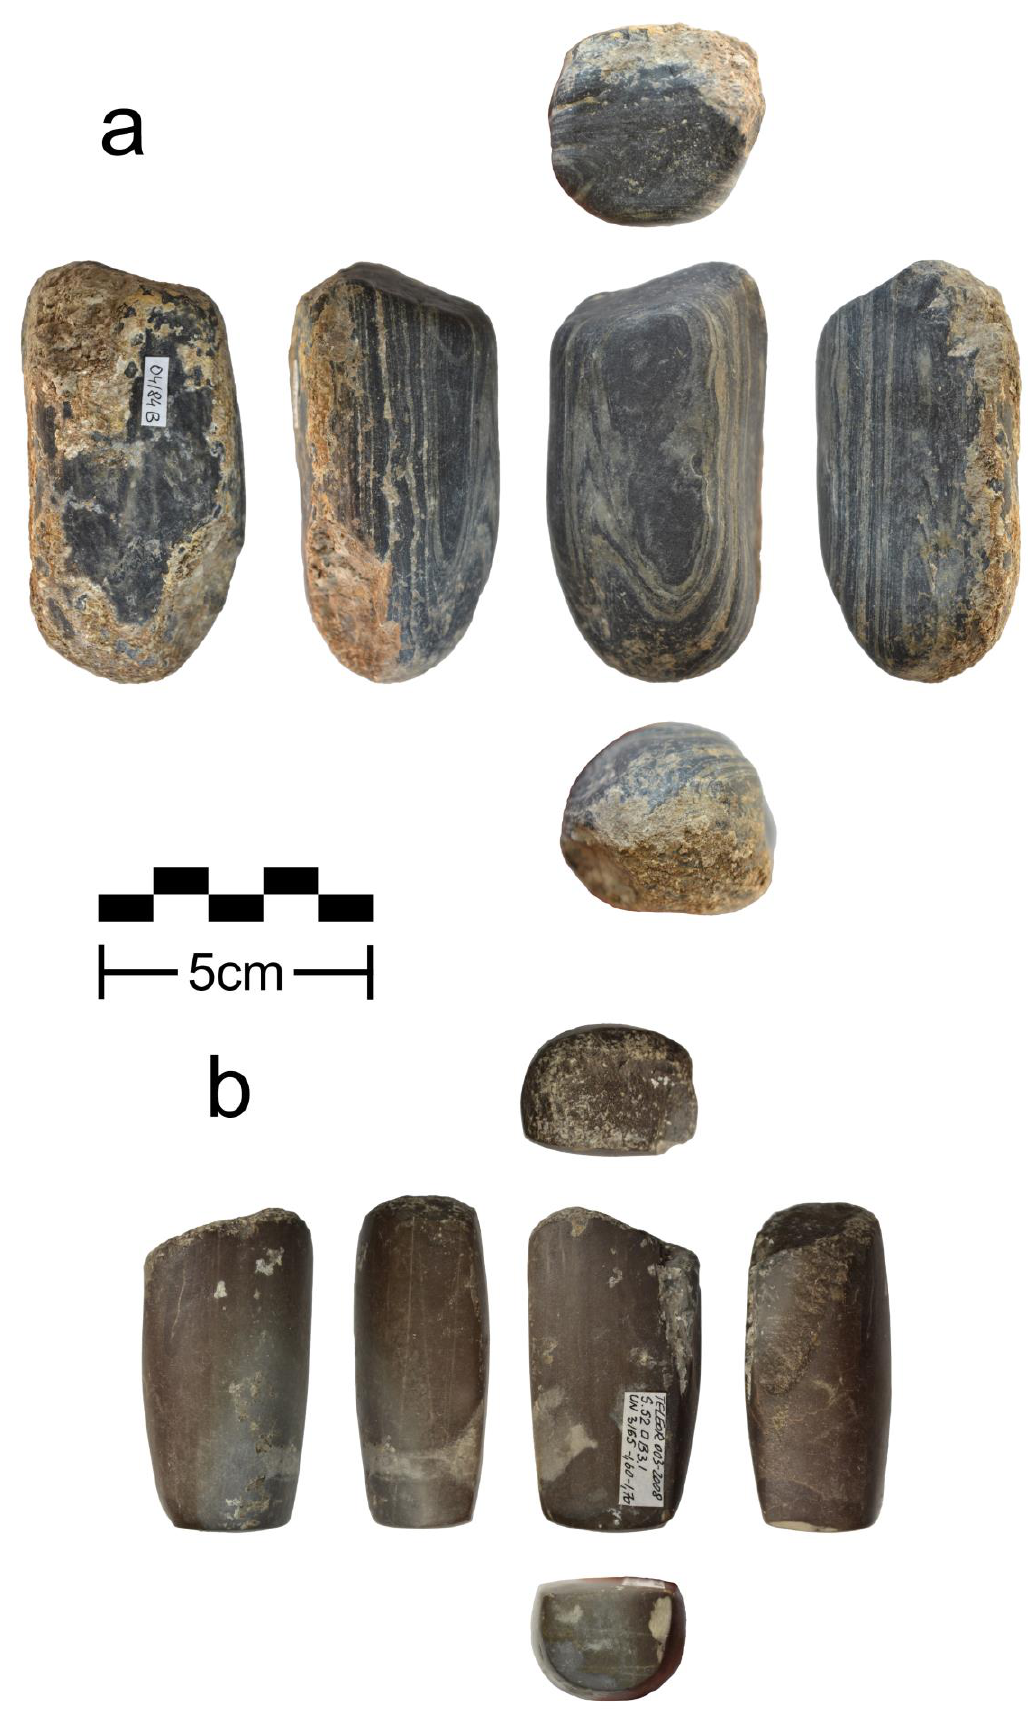
Figure 8. Examples of possible pestles from the Măgura ‘Buduiasca’